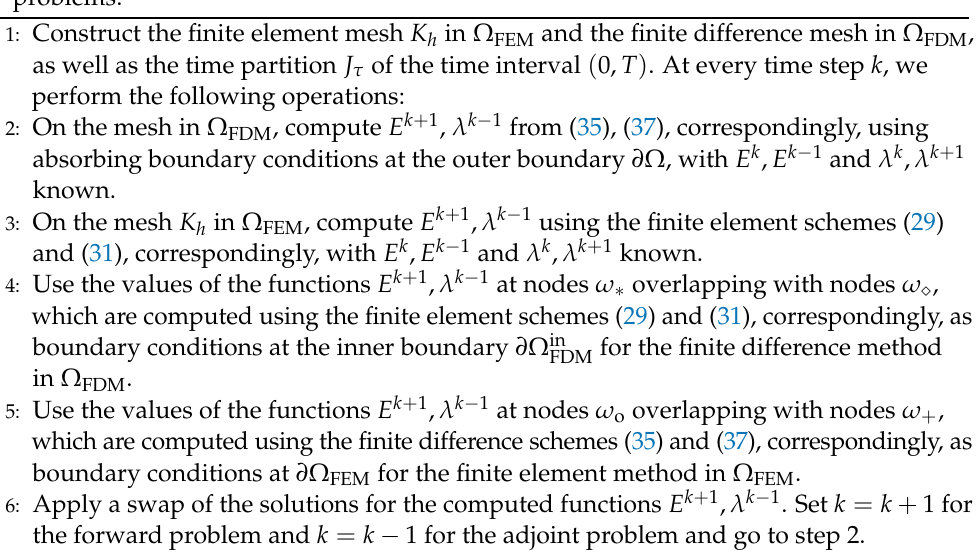
Algorithm 2: The domain decomposition algorithm to solve forward and adjoint